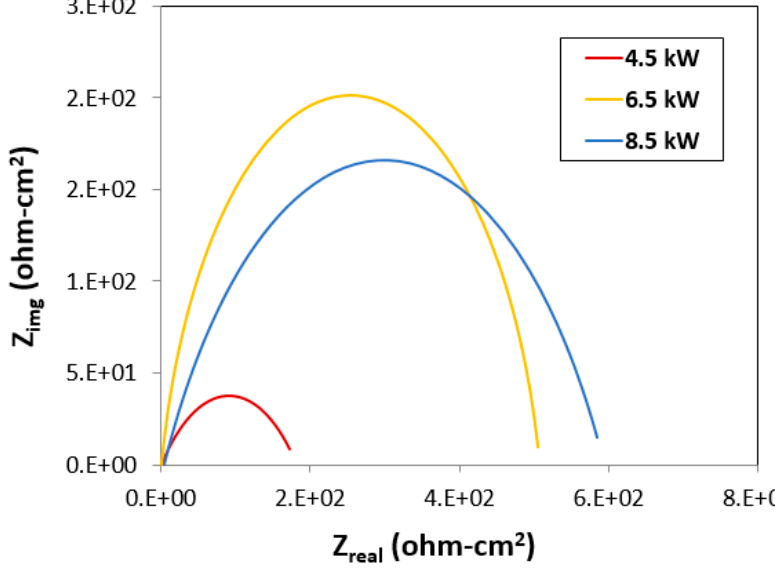
Figure 5. Nyquist plot of 2205 duplex stainless steel in 3.5% NaCl solution.